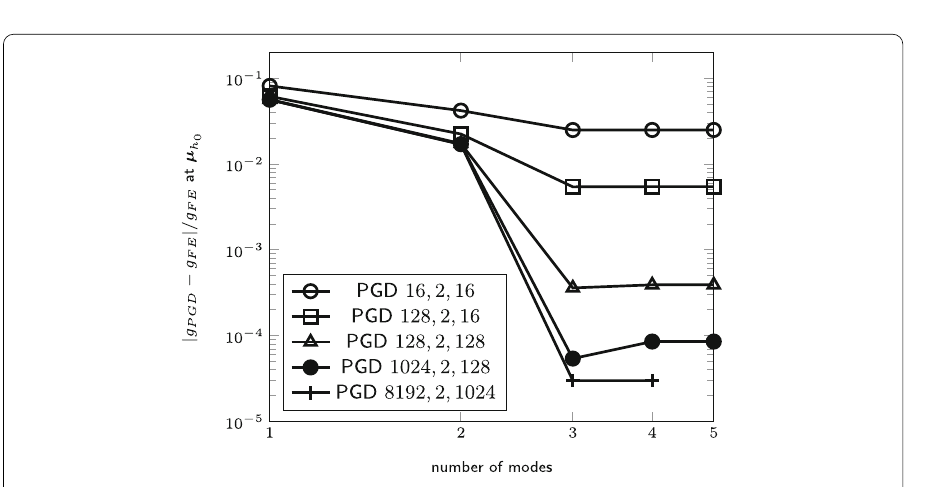
Fig. 6 1D truss: error of the FE solution (mesh in x ) g FE ( μ h number of elements ( itPGDrel-ref step 1)